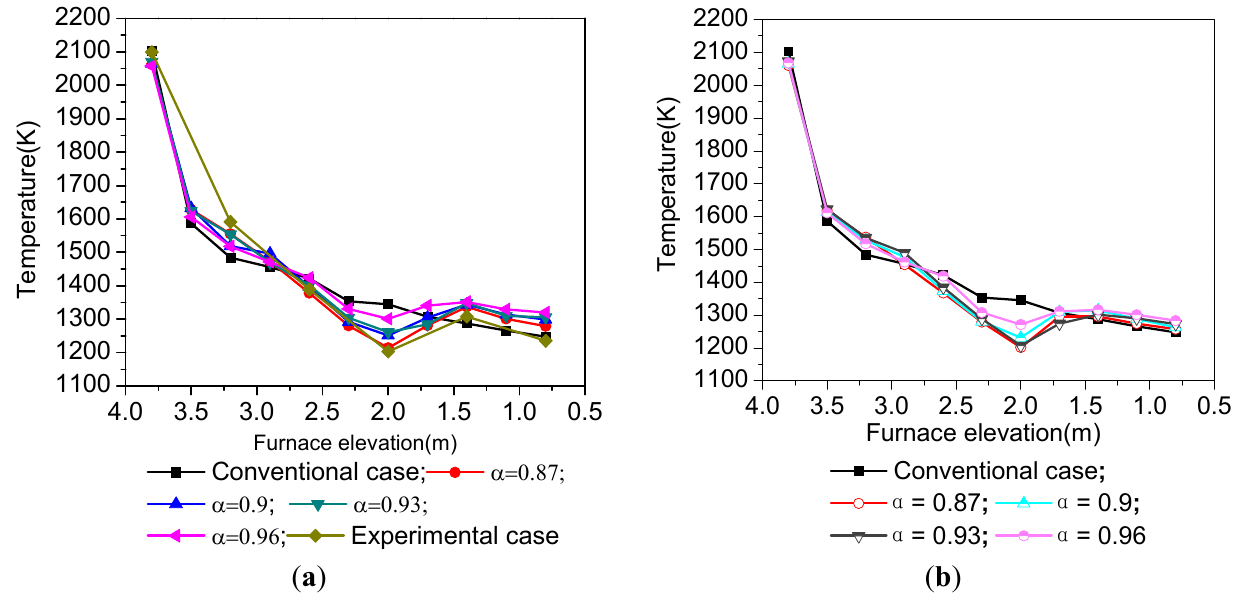
Figure 2. Temperature distributions along with the height of the furnace under different α : ( a ) SAm reburning; and ( b ) cornstalk